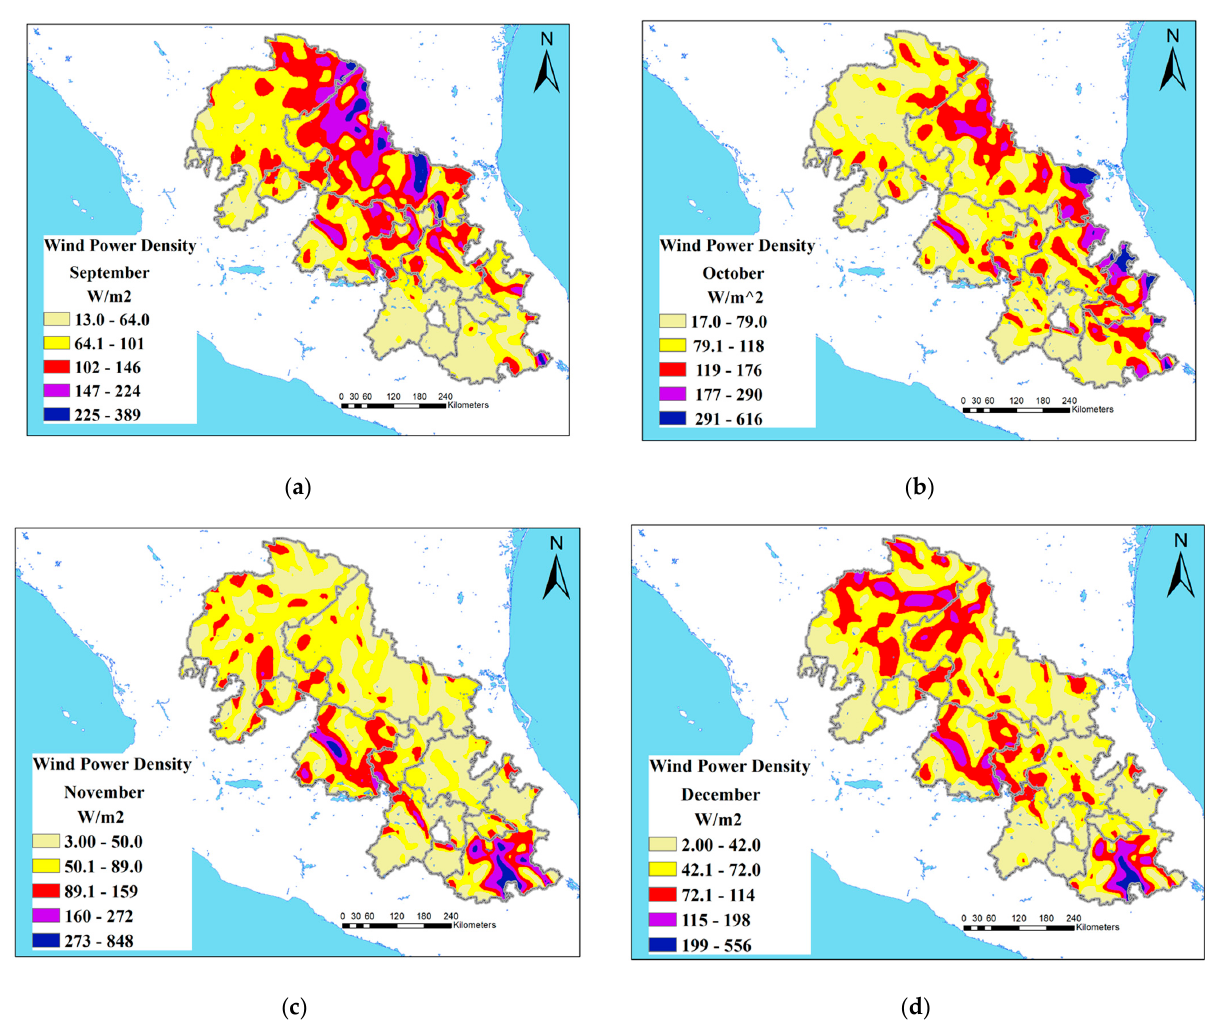
Figure 16. WPD in Central Mexico in ( a ) September, ( b ) October, ( c ) November and ( d ) December. Figure 17 shows the annual WPD map for the central region of Mexico.